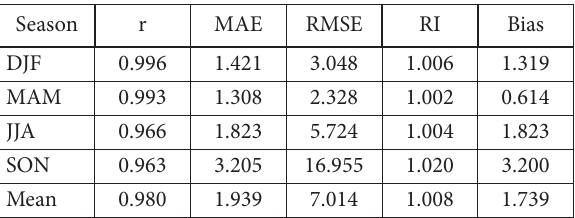
Table 3. Seasonal statistics of ERA5 and NGL PWV Season r MAE RMSE RI